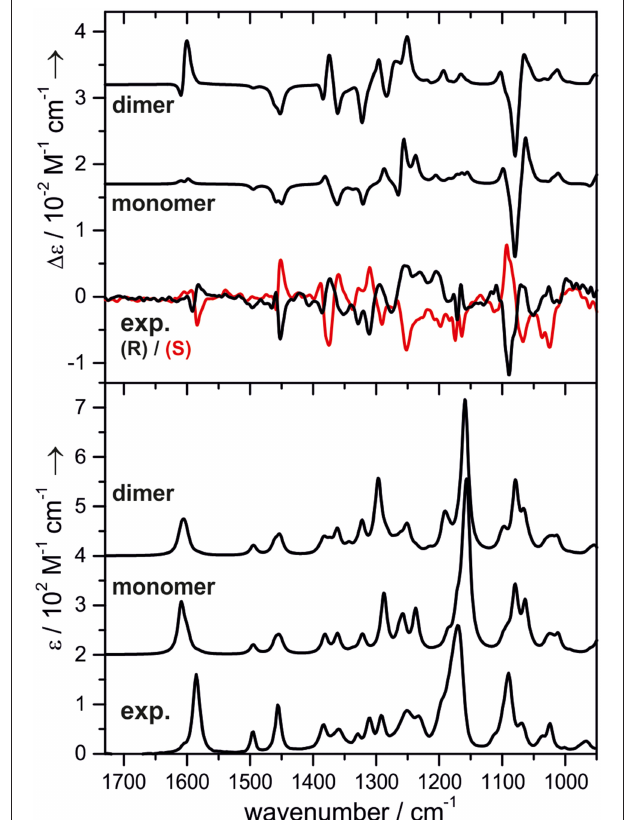
FIGURE 3 | Experimental and calculated VCD (top) and IR spectra (bottom) of methylbenzyl-amine-borane. The calculated spectra are offset for clarity. Reproduced with permission from Merten et al. (2014a,b). Copyright 2014, Wiley-VCH Verlag GmbH & Co. KGaA,